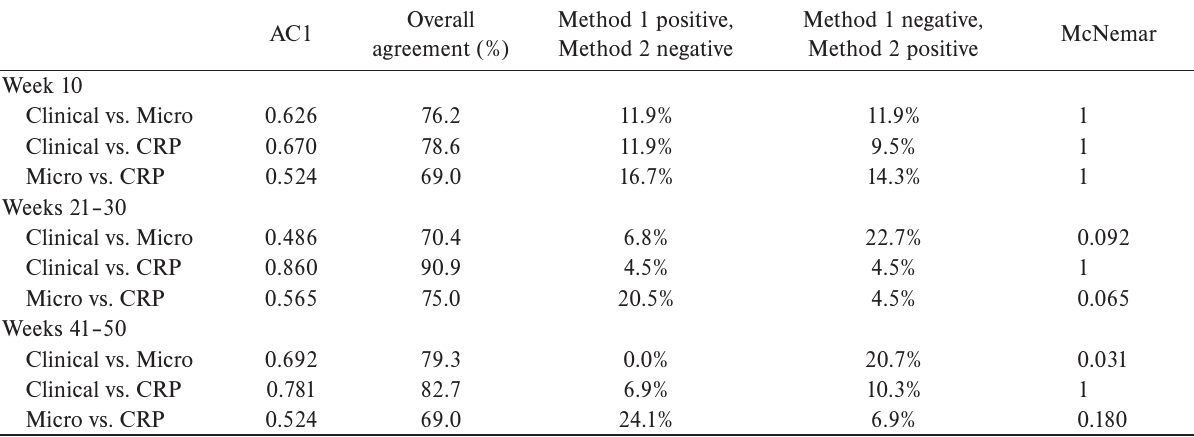
table 1. Evaluation of agreement between the clinical signs, microbiological test result of the hemodialysis cannula swab and CRP at 10, 21–30, and 41–50 weeks after AVG insertion.